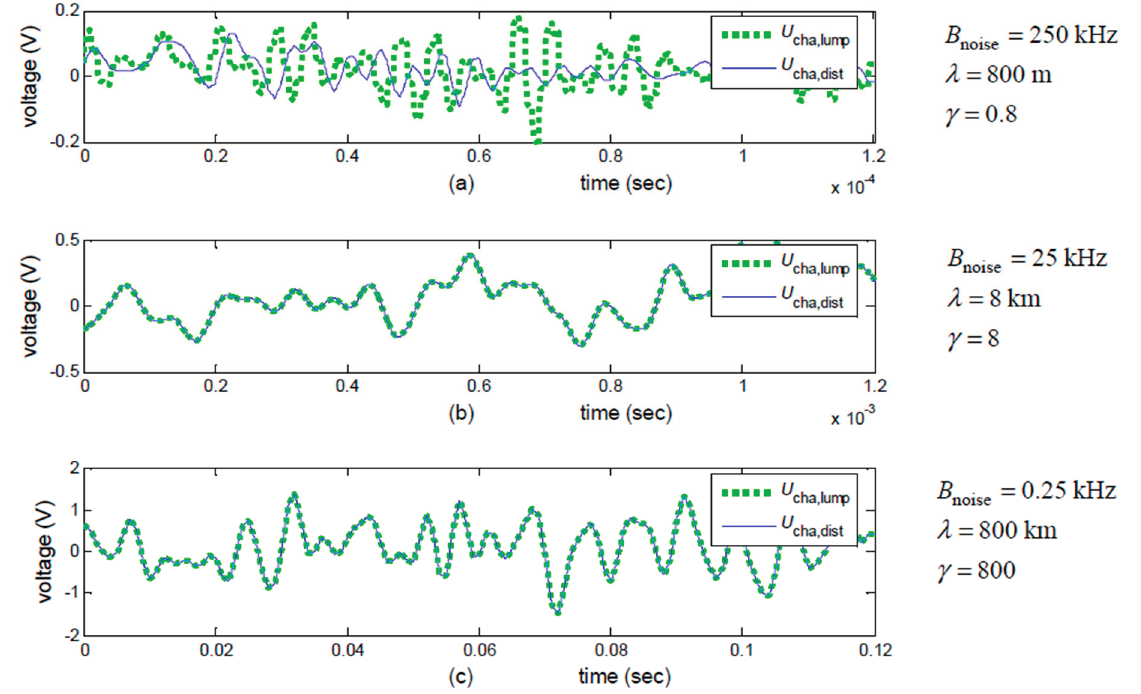
U and U , for the lumped and cha,lump cha,dist